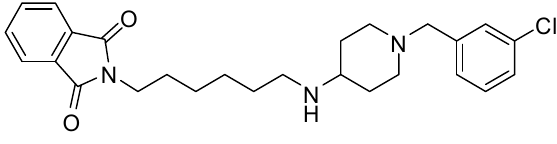
Figure 8. The obtained derivative 3 , based on our library of